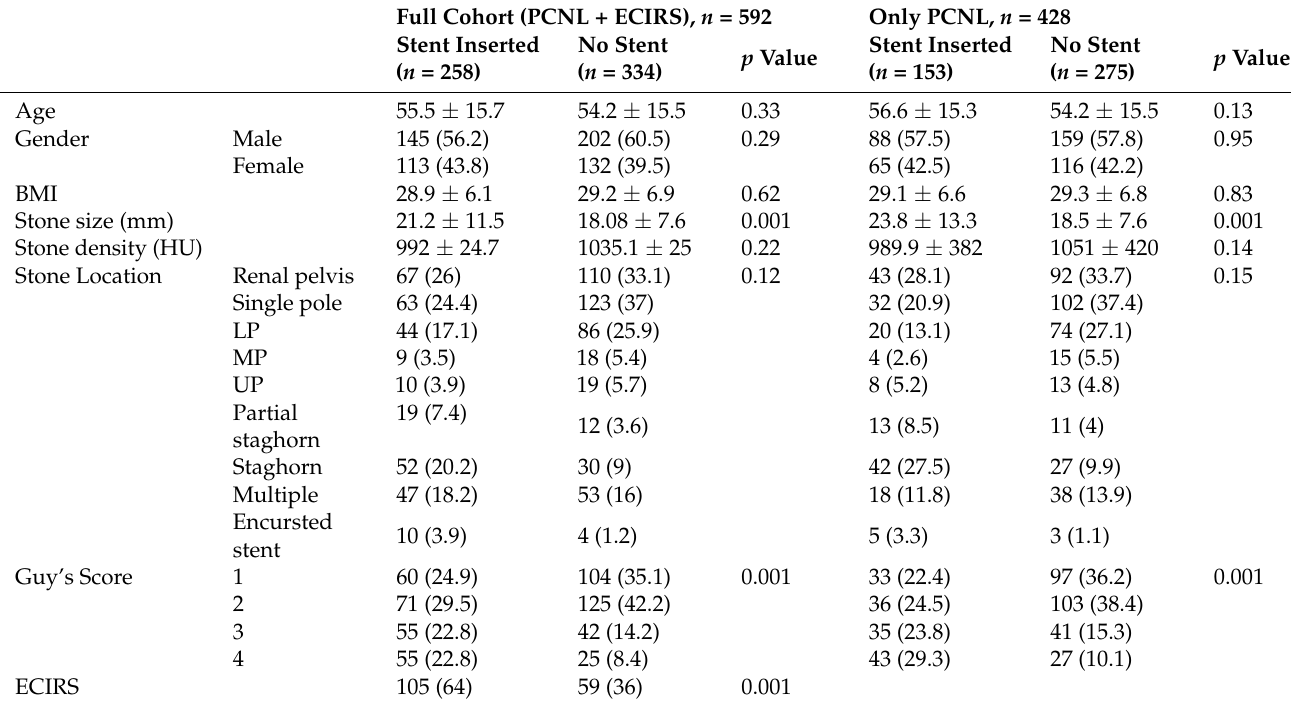
Table 4. Risk factors for stent